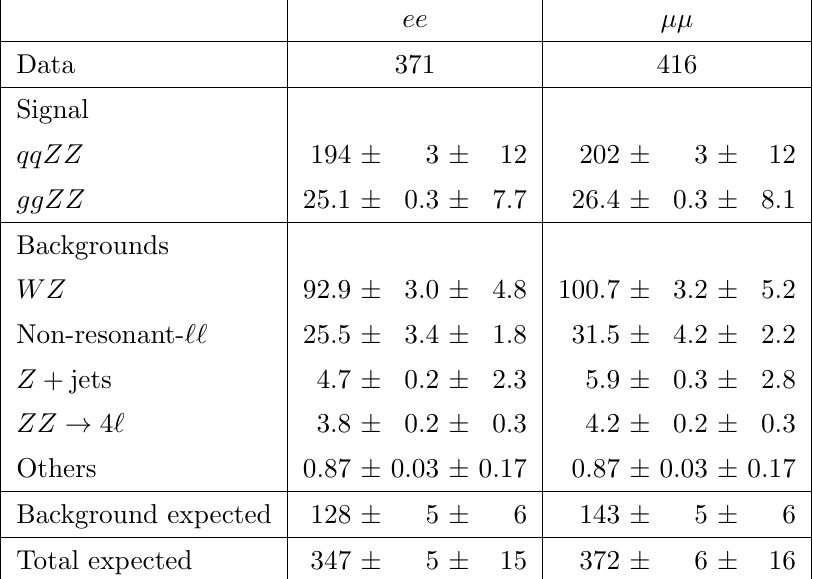
Table 6 . Observed data yields and expected signal and background contributions, shown separately for the ee and (cid:22)(cid:22) channels. The errors shown for the expected yields correspond to the statistical and systematic contributions in that order. The expected background and signal+background yields are shown in the last two rows, where the uncertainties are computed as the sum in quadrature of those from the individual processes.